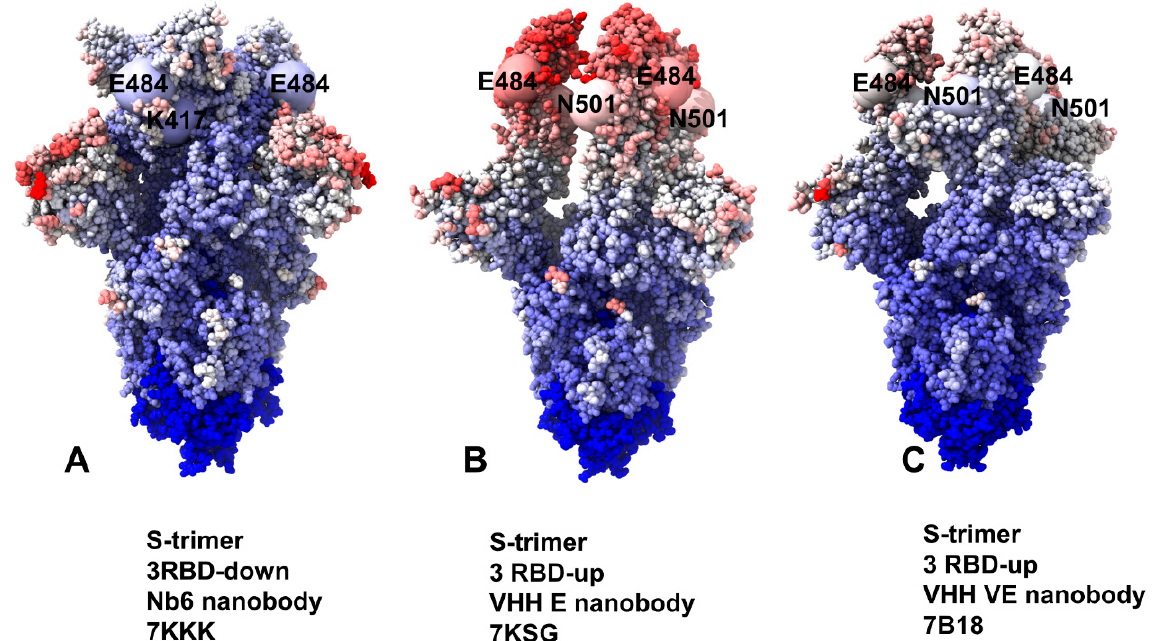
Figure 3. Structural maps of the conformational mobility profiles for the SARS-CoV-2 S protein variants obtained from CG-CABS simulations. The dynamics maps for the SARS-CoV-2 S trimer in the complex with Nb6 nanobody, pdb id 7KKK ( A ), S trimer in the complex with VHH E nanobody, pdb id 7KSG ( B ), and S trimer in the complex with VHH E/VHH V nanobody, pdb id 7B18 ( C ). The structures are in sphere-based representation rendered using UCSF ChimeraX [108] with the rigidity-to-flexibility sliding scale colored from blue to red. The positions of sites of circulating mutations K417, E484, and N501 are shown in large spheres and highlighted for the protomers. The structural maps are projected onto the original cryo-EM structures.